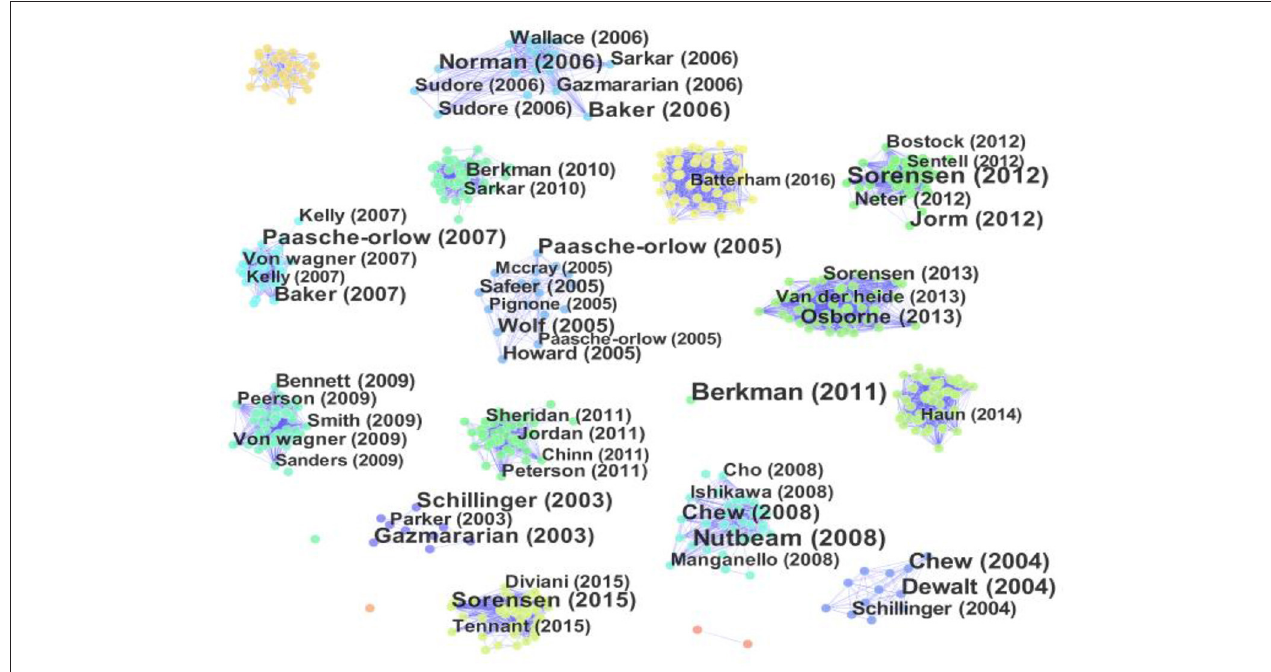
FIGURE 6 | Visualization on highly cited papers articles in health literacy